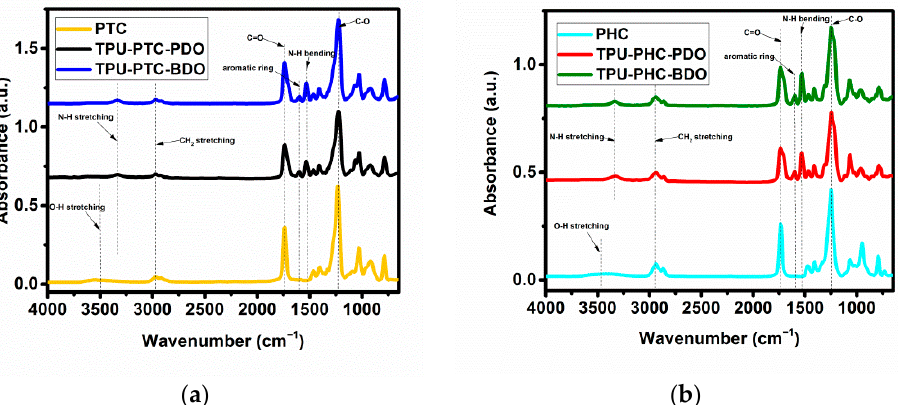
Figure 3. FT ‐ IR spectrum of ( a ) PTC, TPU ‐ PTC ‐ PDO, and TPU ‐ PTC ‐ BDO; and ( b ) PHC, TPU ‐ Figure 3. FT-IR spectrum of ( a ) PTC, TPU-PTC-PDO, and TPU-PTC-BDO; and ( b ) PHC, TPU-PHC- PHC ‐ PDO, and TPU ‐ PHC ‐ BDO. PDO, and